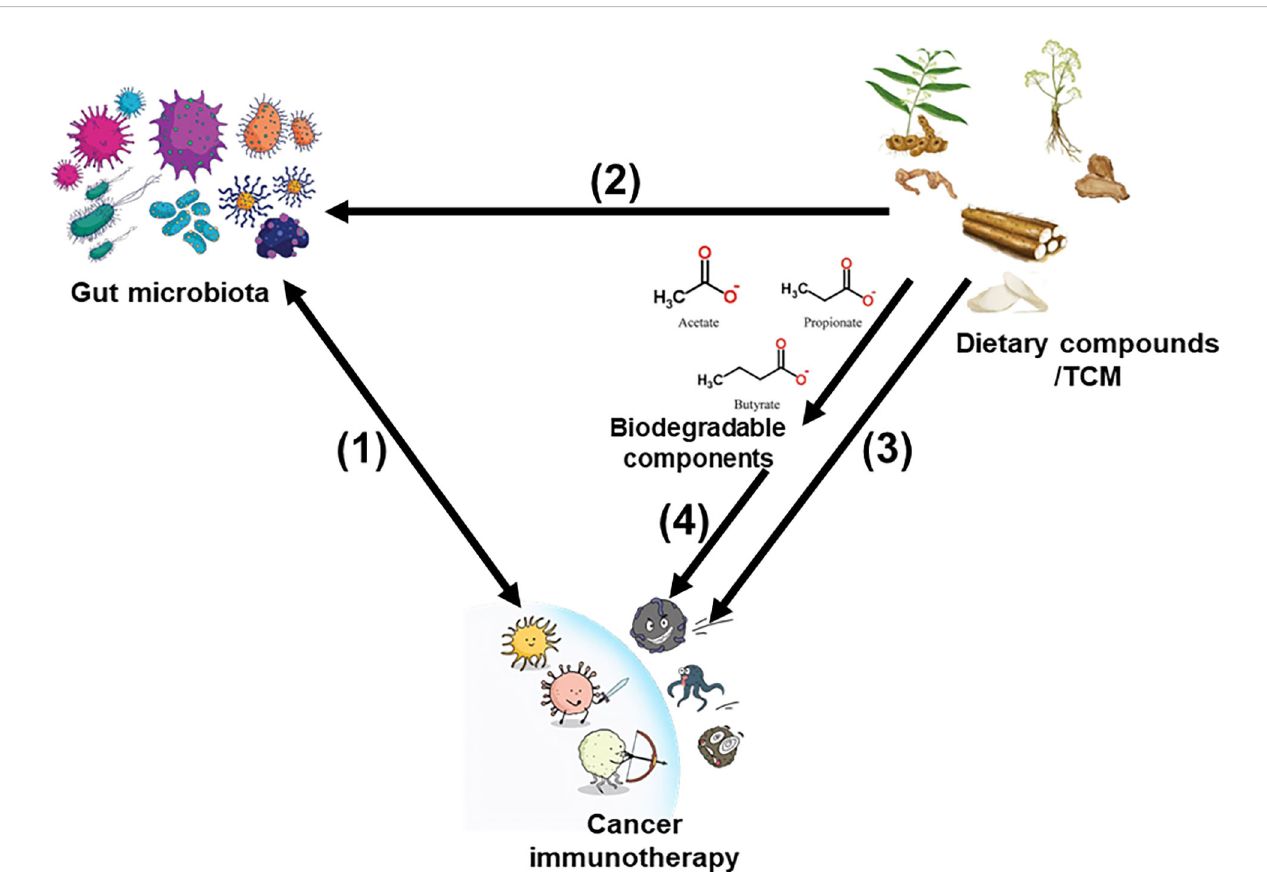
FIGURE 1 Links betweencancer immunotherapy, dietary compounds/TCM, and gut microbiota. (1) The relationship between gut microbiota and cancer immunotherapy is bidirectional. (2) Dietary compounds/TCM modulate gut microbiota composition and metabolism. (3) Dietary compounds/TCM can directly improve the immune system. (4) Biodegradable components produced by intestinal microbiota derived from dietary compounds/TCM also improve cancer immunotherapy